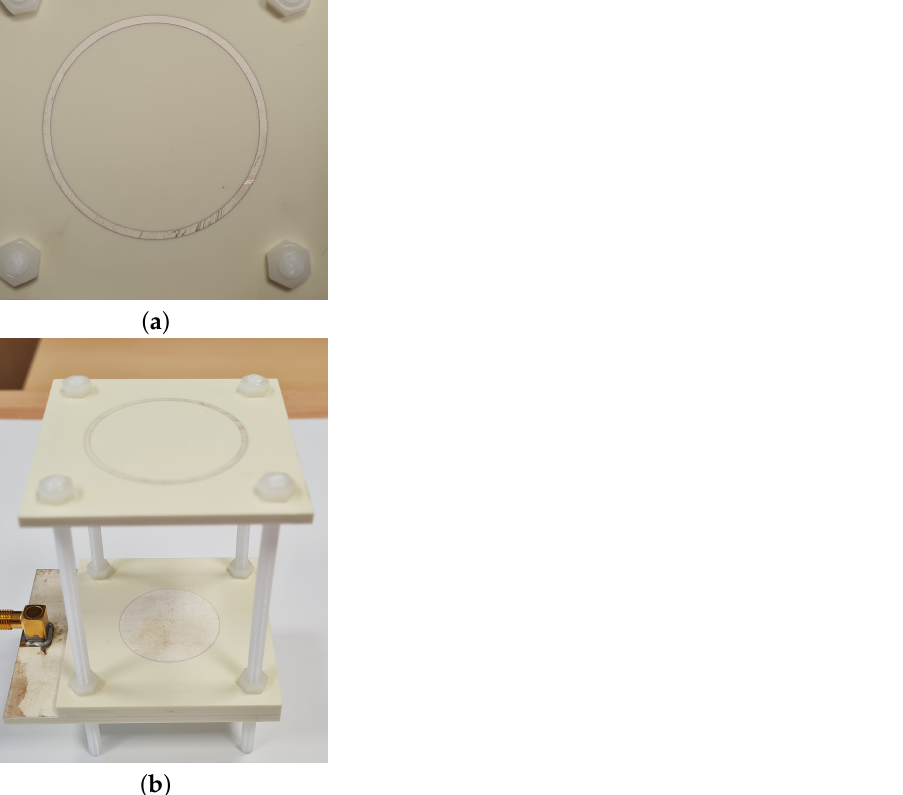
Figure 19. Experimental Assessment —Picture of the fabricated prototype: ( a ) top and ( b ) lateral views.